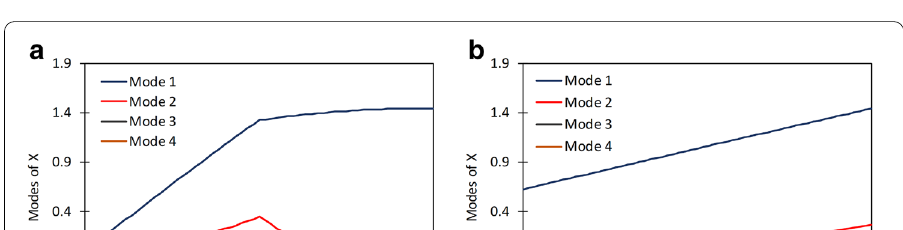
Fig. 1 Domain geometry ( a ) and control net for the construction of the NURBS representation ( b )